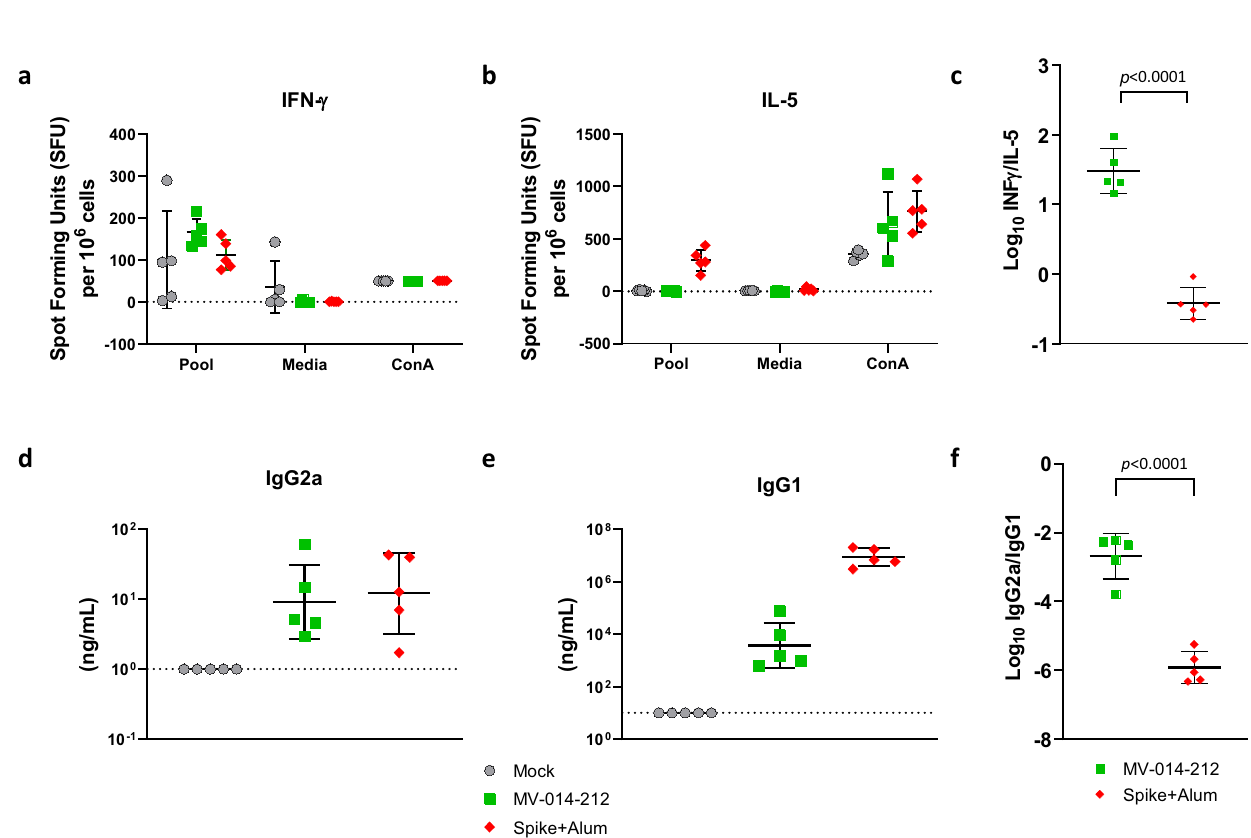
Fig. 6 MV-014-212 elicited a type 1 T helper cell-biased immune response in human ACE2 transgenic mice. a Interferon (IFN)- γ and b interleukin (IL)-5 expressing T cells were quanti fi ed by ELISpot. Splenocytes isolated from mice expressing human ACE2 ( N = 5 mice per group) were collected on day 28 post-inoculation with MV-014-212 or phosphate-buffered saline (PBS) and stimulated with a peptide pool that spanned the SARS-CoV-2 spike protein (pool), media, or the mitogen concanavalin A (Con A). Control mice were vaccinated with puri fi ed SARS-CoV-2 spike protein adjuvanted with alum by intramuscular injection at day − 20 and day 0. c Log of the ratio of IFN- γ to IL-5 – expressing cells. Immunoglobulin levels of d IgG2a and e IgG1 from day 28 serum were determined by Spike-speci fi c ELISA. The concentration of each immunoglobulin isotype was determined from standard curves generated with puri fi ed SARS-CoV-2 spike speci fi c monoclonal IgG2a or IgG1 antibodies. f Log of the ratio of IgG2a/IgG1. Each data point corresponds to one animal. For ( a ), ( b ), ( c ), and ( f ), the horizontal bar marks the mean and error bars are SD. For ( d ) and ( e ), the horizontal bars are the geometric mean and error bars are geometric SD. Statistical analysis is an unpaired t report from the Centers for Disease Control and Prevention 52 Direct comparison of the AGM serum nAb titers to serum nAb showed that in breakthrough infections, the viral load in the noses titers published for nonreplicating vaccines in rhesus monkeys or of vaccinated individuals is as high as that of unvaccinated to titers in human convalescent sera is confounded by the semi- subjects. This fi nding and the rapid spread of the highly permissiveness of AGM for MV-014-212 replication. The immuno- transmissible Delta and Omicron variants underscore the urgent genicity of MV-014-212 is currently being studied in an ongoing need for a vaccine that has the potential to block infection in the Phase 1 clinical trial. The intramuscularly administered vaccines currently in use offer nose and reduces transmission. Vaccines delivered intranasally high levels of protection, but their ability to prevent asymptomatic stand a higher chance of eliciting local mucosal immunity, transmission is still unclear (reviewed by Tiboni et al. 51 ). A recent preventing not only systemic infection but also local replication